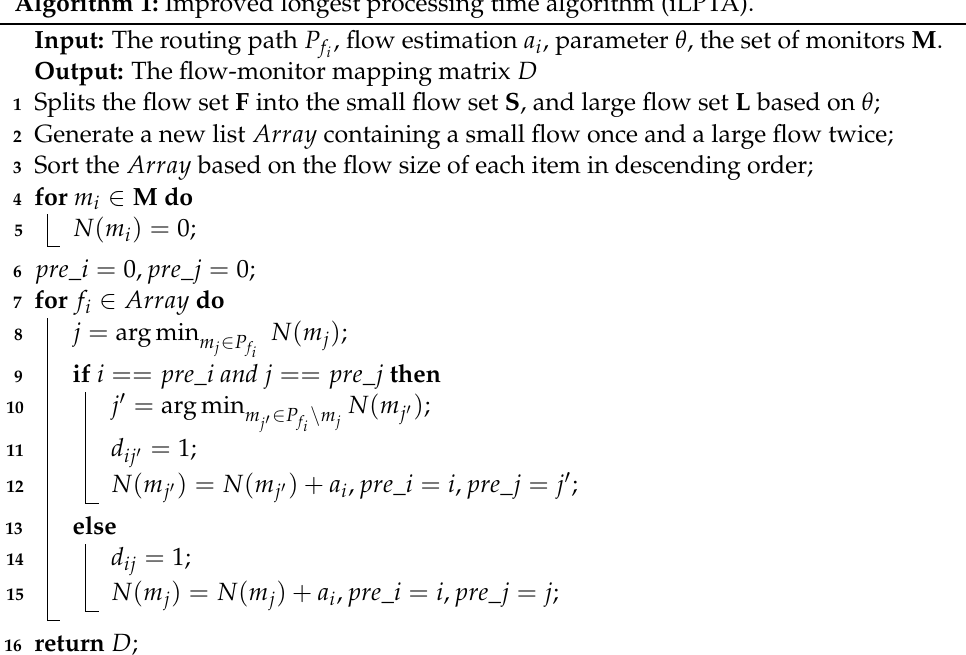
Algorithm 1: Improved longest processing time algorithm